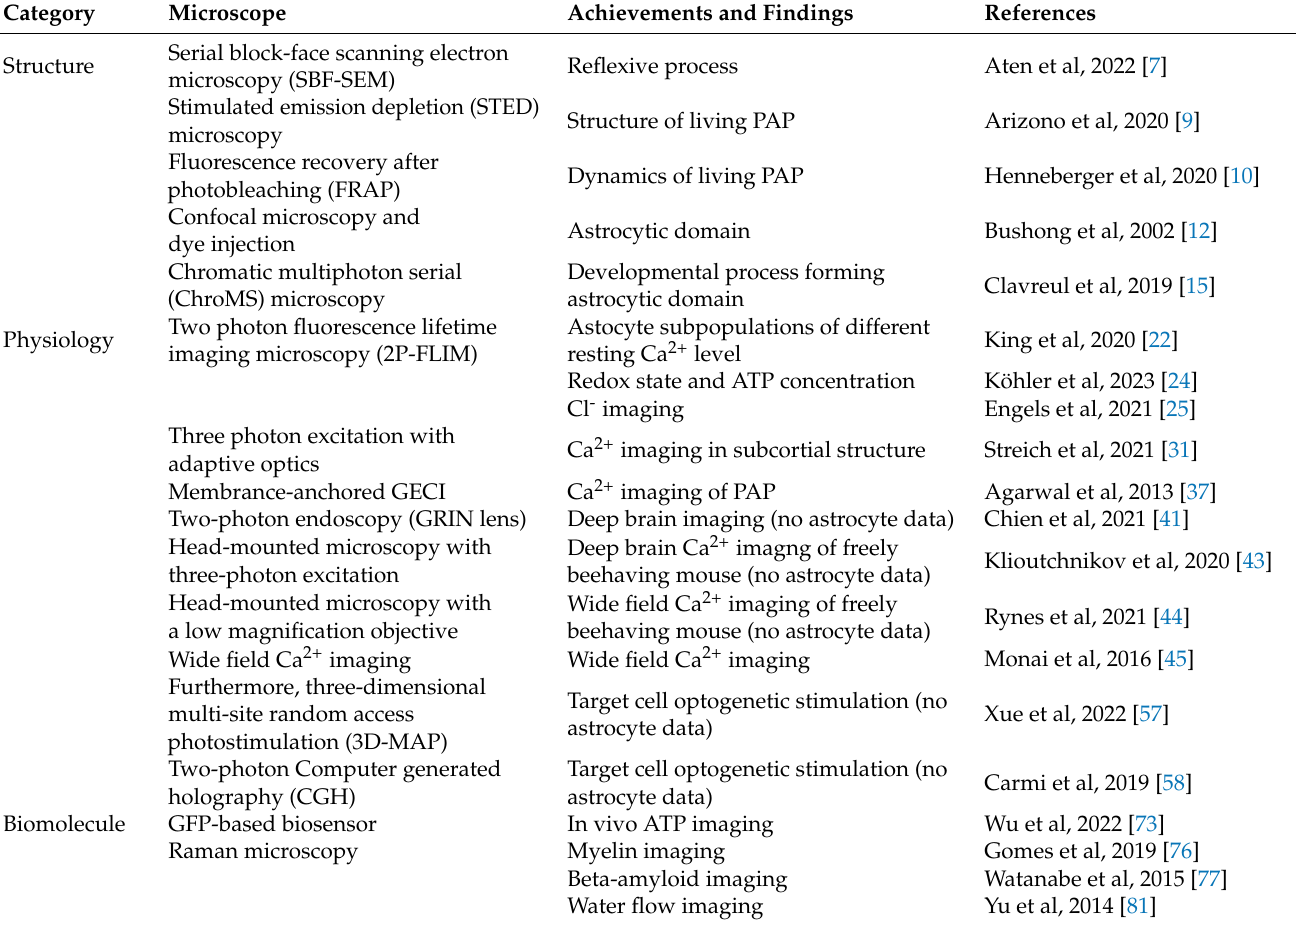
Table 1. Modern microscopic approaches to astrocytes discussed in this